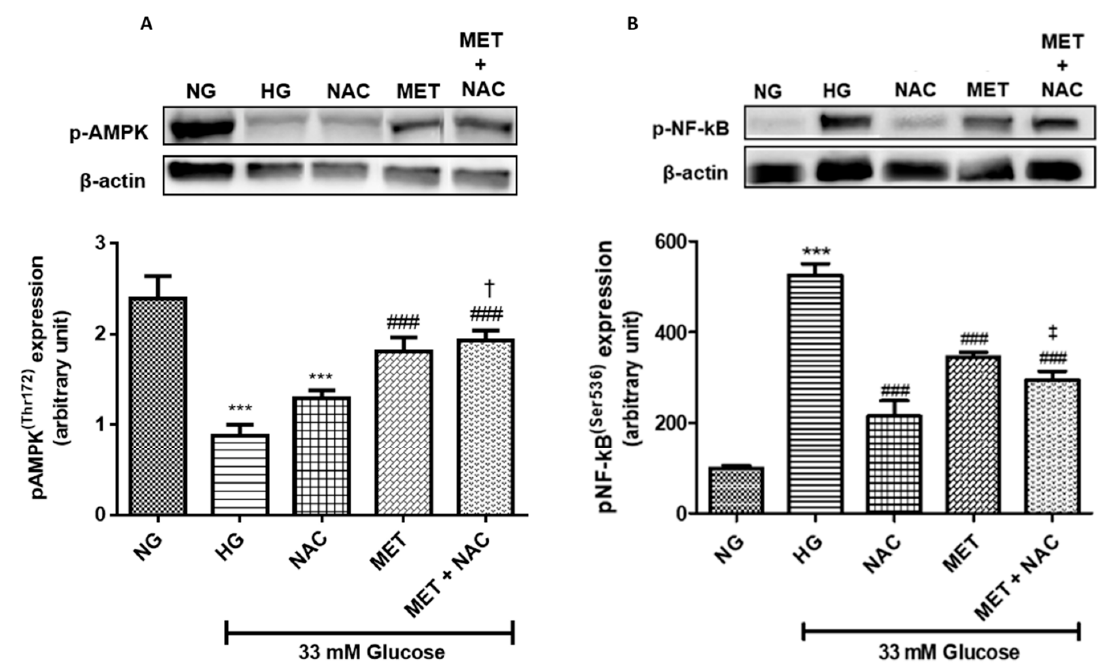
Figure 10. The combination effect of Metformin (MET) and N-acetylcysteine (NAC) on 5’ AMP-activated protein kinase phosphorylation at threonine 172 (p-AMPKThr172) and nuclear factor-kappa B phosphorylation at serine 536 (p-NF-kB (Ser536)). Protein expression of ( A ) p-AMPK(Thr172) and ( B ) p-NF-kB (Ser536) on H9c2 cardiomyoblasts cultured in high glucose (HG; 33 mM) for 24 h. Thereafter, cells were treated with NAC (1 mM), metformin (MET) (1 µ M) and a combination of MET + NAC. Cells treated with normal glucose (NG) served as the vehicle control. Results are expressed as the mean ± SEM of 3 independent biological experiments with each experiment having 3 technical replicates (n = 9). Significance is depicted as *** p ≤ 0.001 versus NG control, ### p ≤ 0.001 versus HG control, † p ≤ versus MET and ‡ p ≤ 0.05 versus